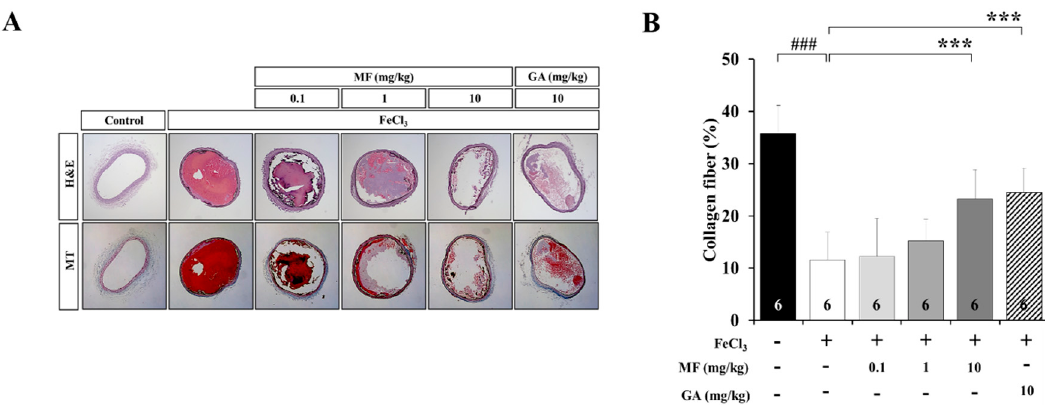
Figure 2. Histological examination of FeCl 3 -induced carotid artery thrombosis after MF treatment. Representative images of H&E and MT staining of vessels ( A ) and blue-stained collagen fibers ( B ), showing that the effects of MF treatment on an FeCl 3 -induced arterial thrombosis model. GA was used as a positive Control drug. Data are expressed as mean ± standard deviation. ### p < 0.001, compared with the Control group; *** p < 0.001, compared with the FeCl 3 group; n = 6 rats per group. MF: mumefural; GA: gingkolide A; H&E: hematoxylin and eosin; MT: Masson’s trichrome.